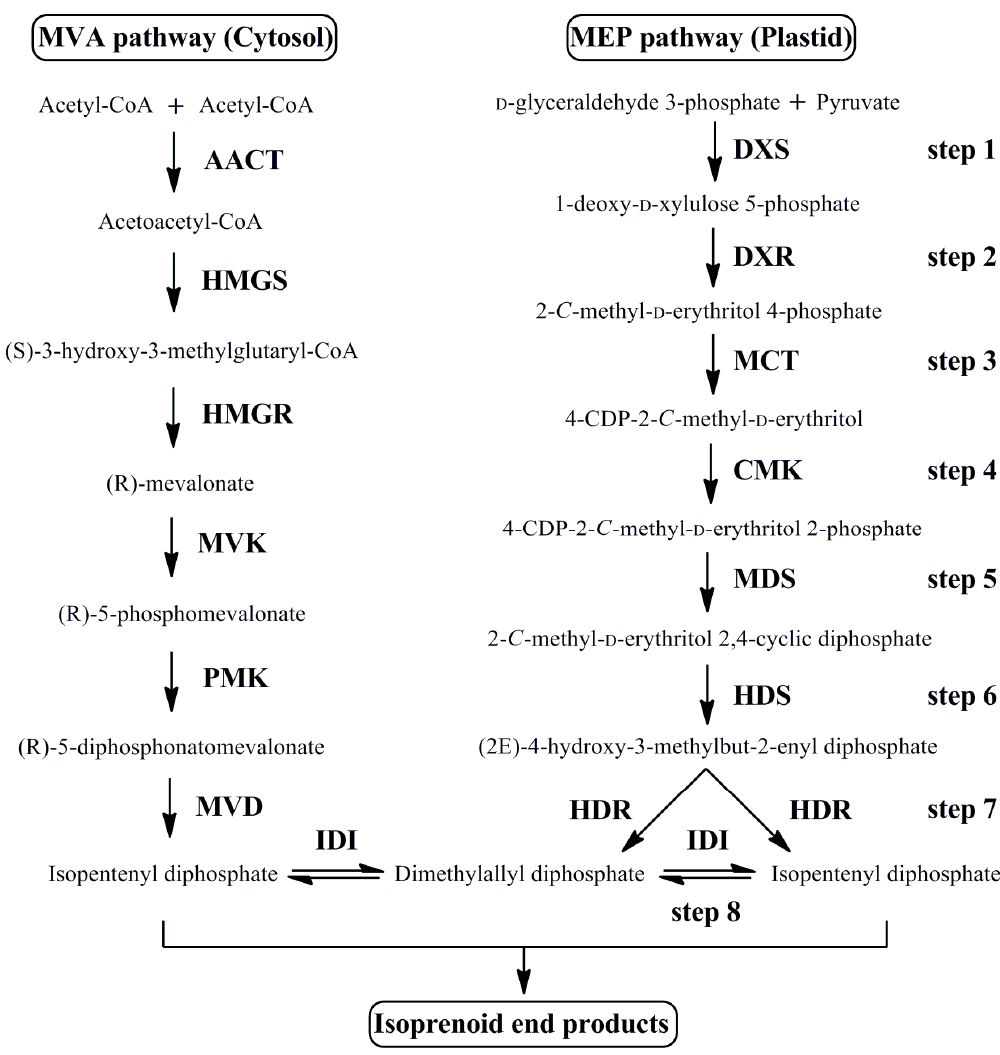
Figure 1. The steps of the MEP pathway leading to Isoprenoid biosynthetic. Enzymes of MEP pathway are as follows: step 1, DXS; step 2, DXR; step 3, MCT; step4, CMK; step 5, MDS; step 6, HDS; step 7, HDR; step 8, IDI.